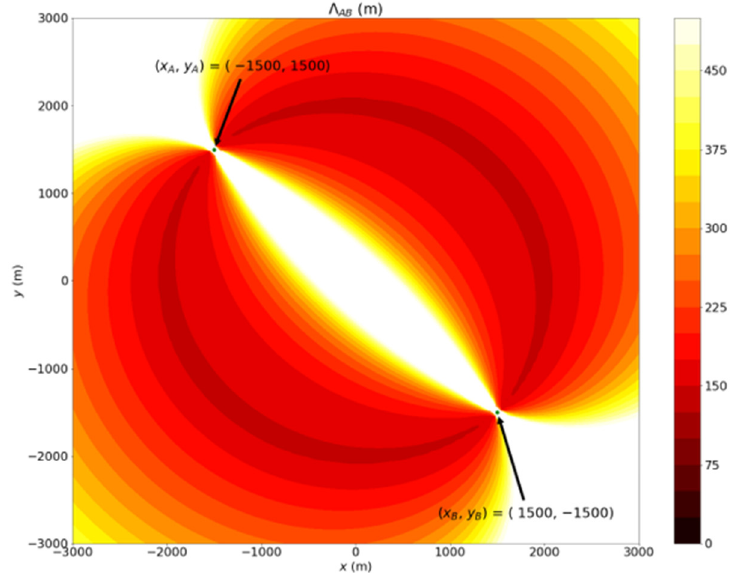
Figure 3. Example of the distribution of Λ AB .